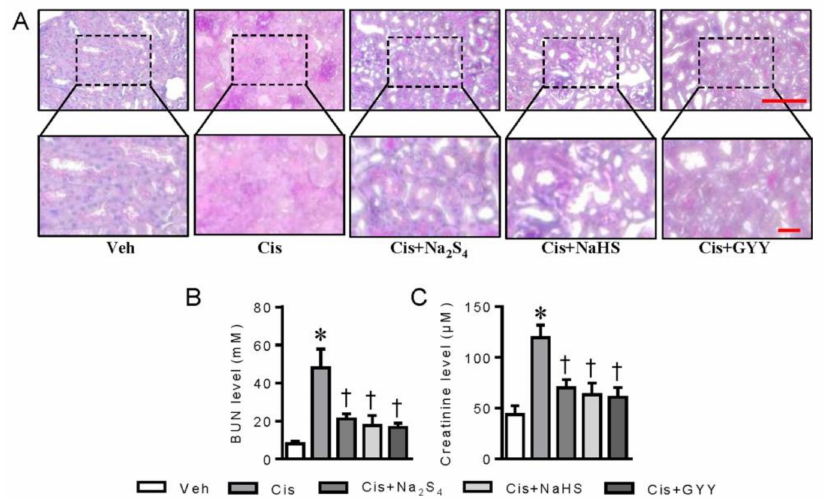
Figure 4. Polysulfide and H 2 S attenuated cisplatin-induced nephrotoxicity in mice. ( A ) Periodic acid-Schi ff (PAS) staining of renal sections. Scale bar = 100 µ m. ( B ) Serum blood urea nitrogen (BUN) levels. ( C ) Serum creatinine levels. * p < 0.05 vs. Vehicle (Veh), † p < 0.05 vs. Cisplatin (Cis). GYY4137 (GYY). n = 5 in each